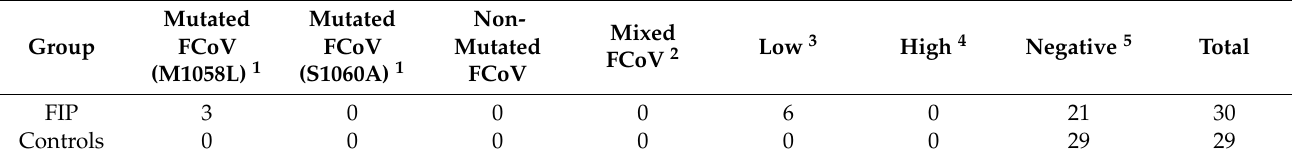
Table 3. Summarized results of the spike (S) gene realtime reverse transcriptase polymerase chain reaction (RT-qPCR) in cats with feline infectious peritonitis (FIP) and control